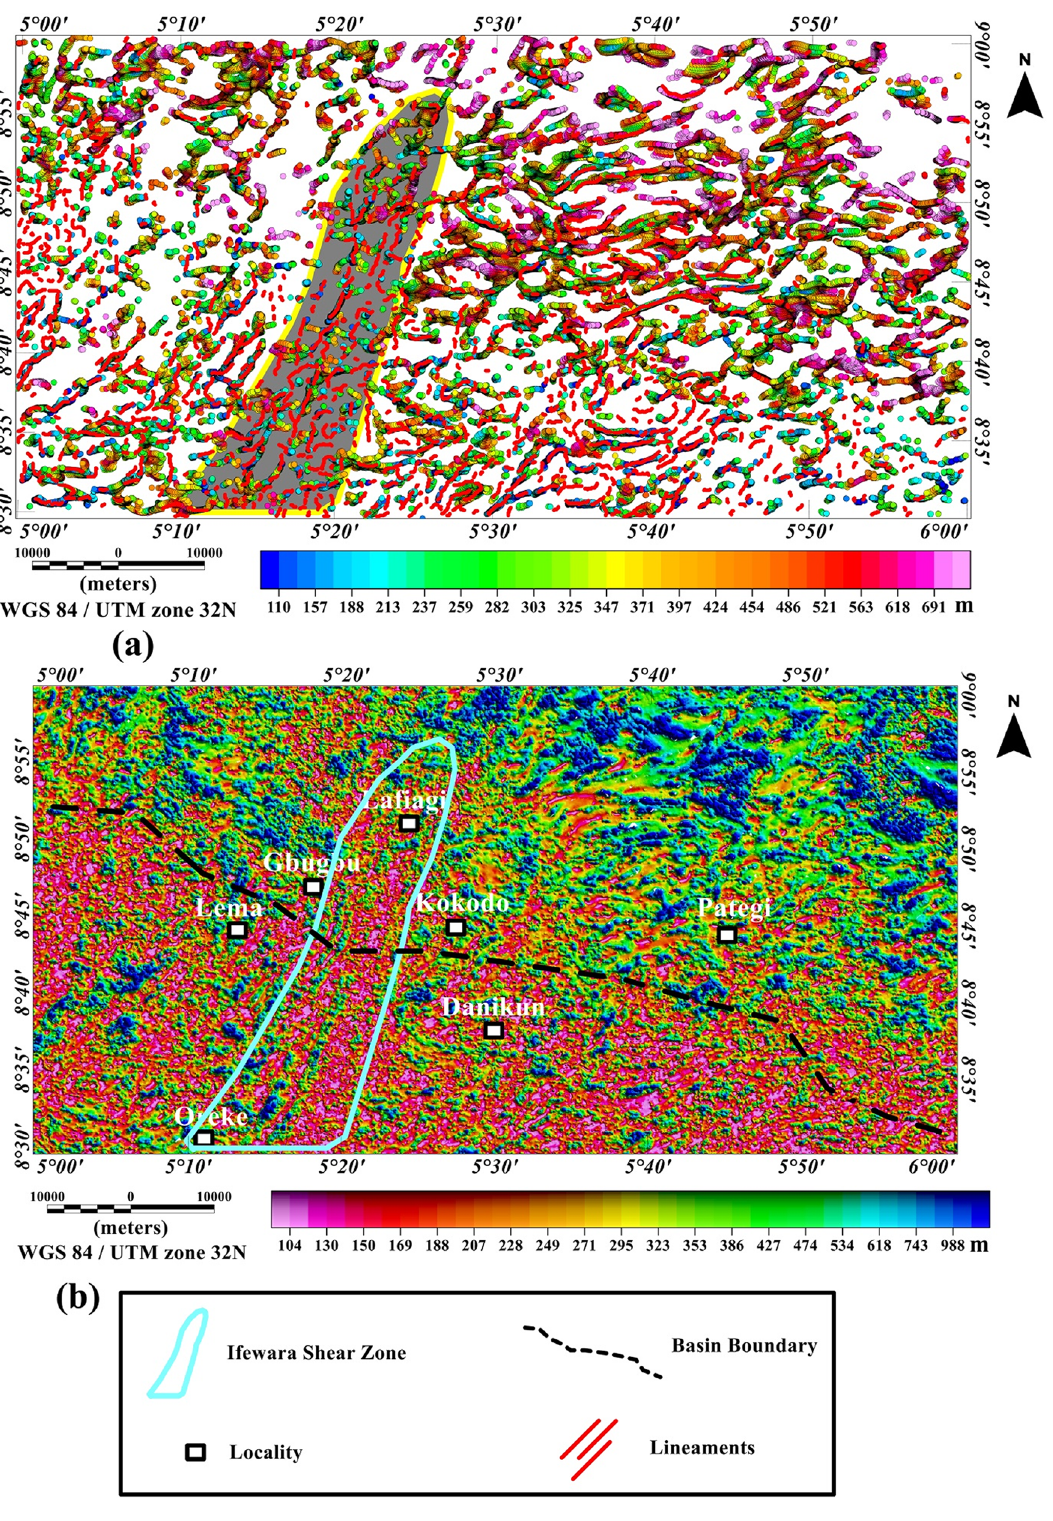
Figure 5. ( a ) 3-D Euler deconvolution depth map generated for SI = 1 using residual magnetic intensity anomaly data of the study area, superimposed with the extracted maxima of the total gradient amplitude in Fig. 4b. Note the 3-D Euler depth solution clusters along the Ifewara shear zone (enclosed in yellow polygon with brown background) and dominant E–W trending 3-D Euler depth solution clusters attributed to pre-Pan-African orogeny are observed in the eastern part of the map. ( b ) Color-shaded source parameter imaging (SPI) depth map of the study area produced from the application of the SPI method on residual magnetic intensity anomaly data of the southern border of the Middle Niger Basin. The blue color polygon indicates the extent of the Ifewara shear zone. The surface from which depths are measured is 80 m which is the sensor mean terrain clearance of the aeromagnetic survey. The figures were produced using Oasis Montaj Software version 8.3.3 (Website: https:// www. seequ ent.